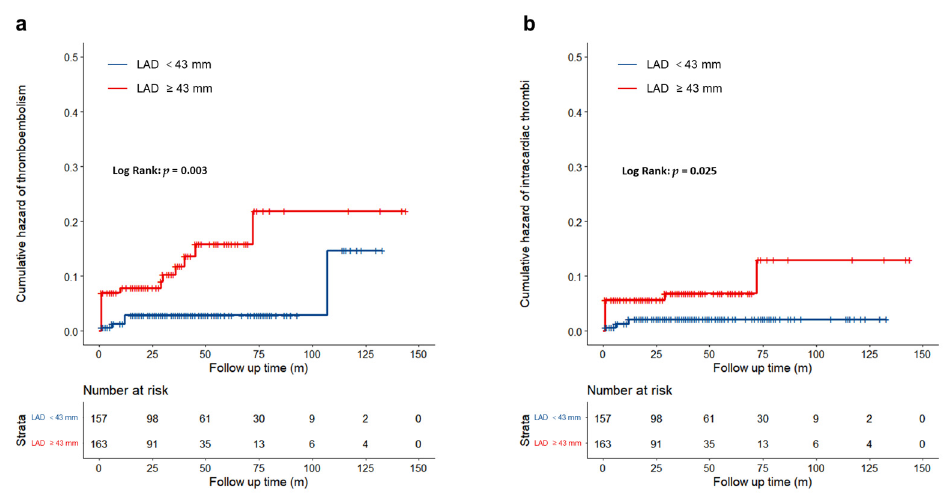
Figure 3. Kaplan–Meier analysis according to left atrial diameter. ( a ): Thromboembolism events; ( b ): Intracardiac thrombi.